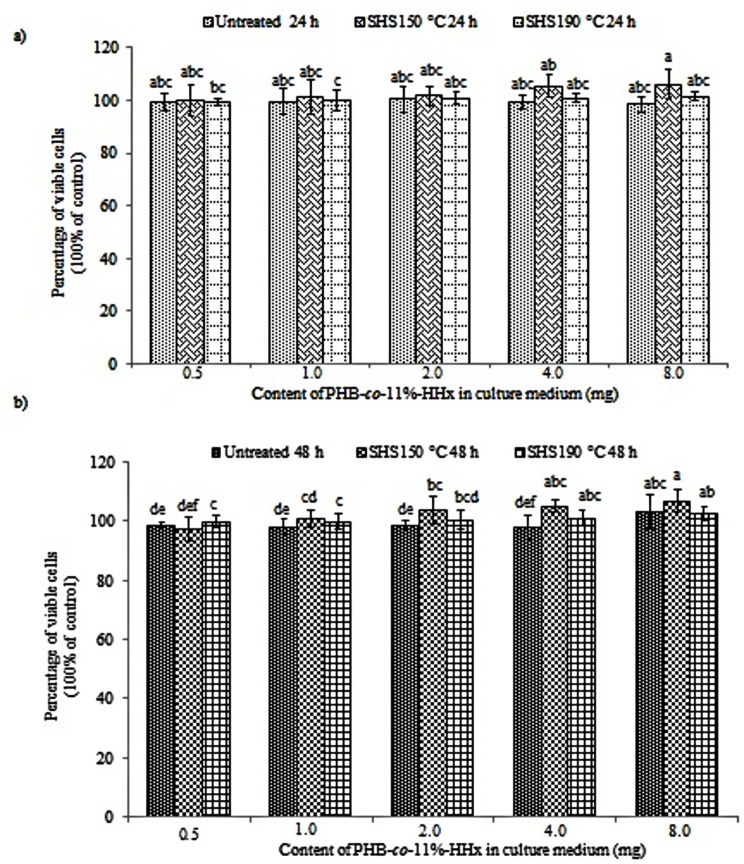
Cell viability of NIH 3T3 cells incubated with untreated and SHS-treated P(HB-co-11%-HHx) samples.(a) Cell cultured for 24 and (b) 48 h. The mean data denoted by different superscript letters are significantly different (Duncan’s multiple range test, p < 0.05).